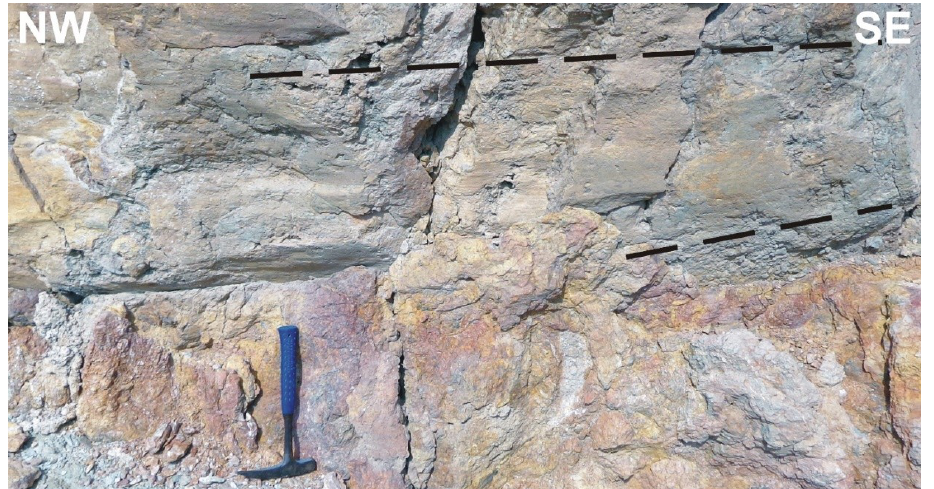
Figure 15. Part of the large slickenside in the Hiyam Formation of the Wadi Amdeh Fault with horizontal slickenlines (black dashed lines). The slickenside marks the contact between the Amdeh and Hiyam formations.